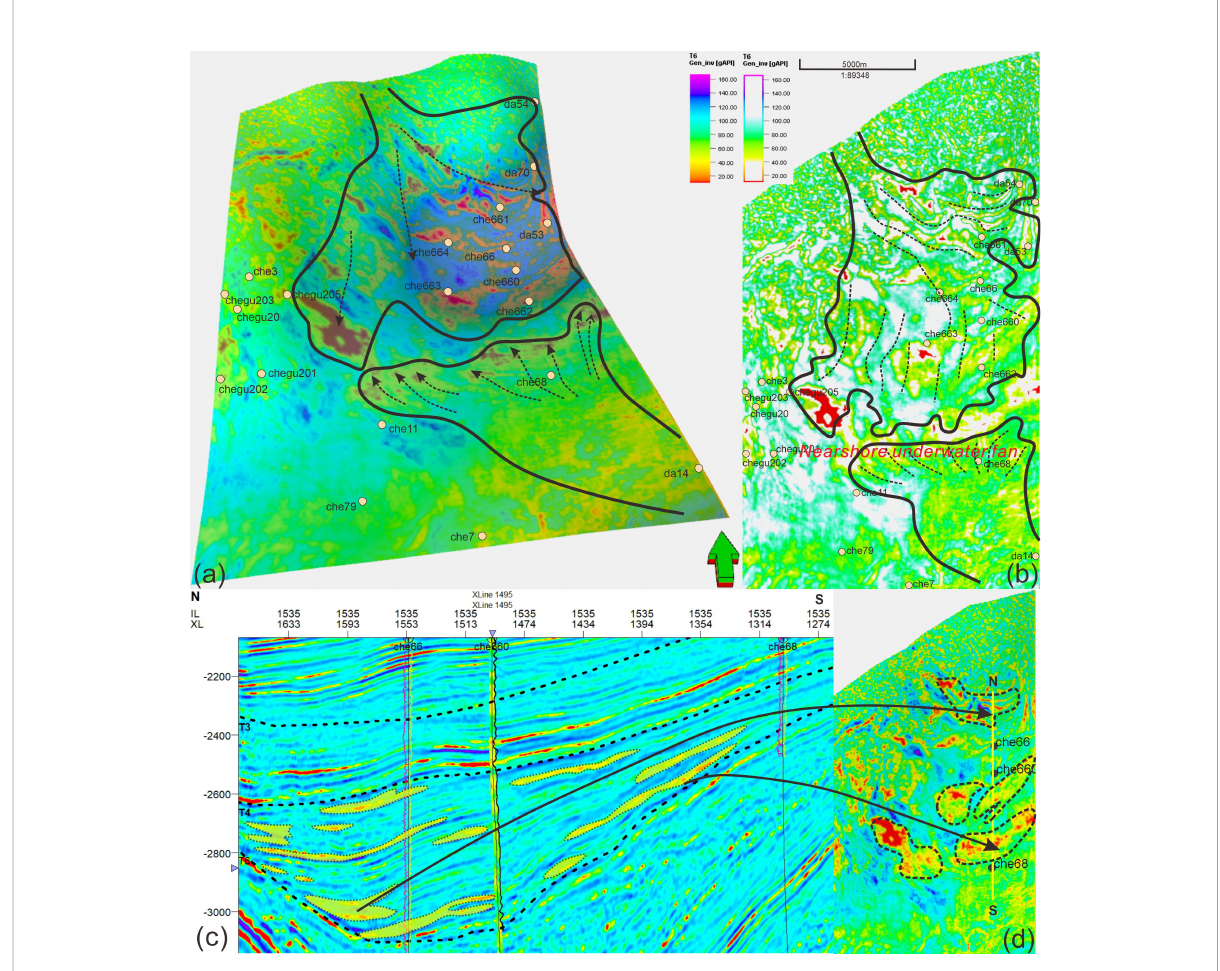
FIGURE 9 Inversion stratigraphic slice and pro fi le of P 2 S 3X . (A) Multiattribute fusion technology - superposition map from GR genetic inversion stratigraphic slice and structural map. The black curve represents a fan. Red and yellow represent GR low values, representing gravelly sandstone. Based on the 3D structural map, it is inferred that two fans were developed in this area: one was from the northern mountainous area, and the other was from the southern mountainous area. (B) GR genetic inversion stratigraphic slices after fi ltering high and very low values. This fi gure can depict the fan more clearly. The black curve represents a fan. (C) GR genetic inversion pro fi le. T3 is the top of P 2 S 3S . T4 is the top of P 2 S 3Z . T6 is the bottom of P 2 S 3X . The red curve on the left side of Well che66 is the GR curve (the curve protruding to the right indicates a low GR value), and the yellow curve on the right is the AC curve (the curve protruding to the left indicates a low AC value). The middle axis of the che660 well is the extracted above-well Freq attribute, and red and yellow are high values, representing gravelly sandstone. The black curve on the right is the AC curve (the curve highlighted to the left indicates that the AC value is low). The red curve on the left of Well che68 is the GR curve (the curve protruding to the right indicates a low GR value), and the yellow curve on the right is the AC curve (the curve protruding to the left indicates a low AC value). The yellow area circled by the dotted point is gravelly sandstone delineated from the pro fi le. (D) Un fi ltered GR genetic inversion stratigraphic slices with high and very low values. The black dotted line is the distribution range of gravelly sandstone fi nally delineated on the plane. The yellow straight line is the location of Section (C)